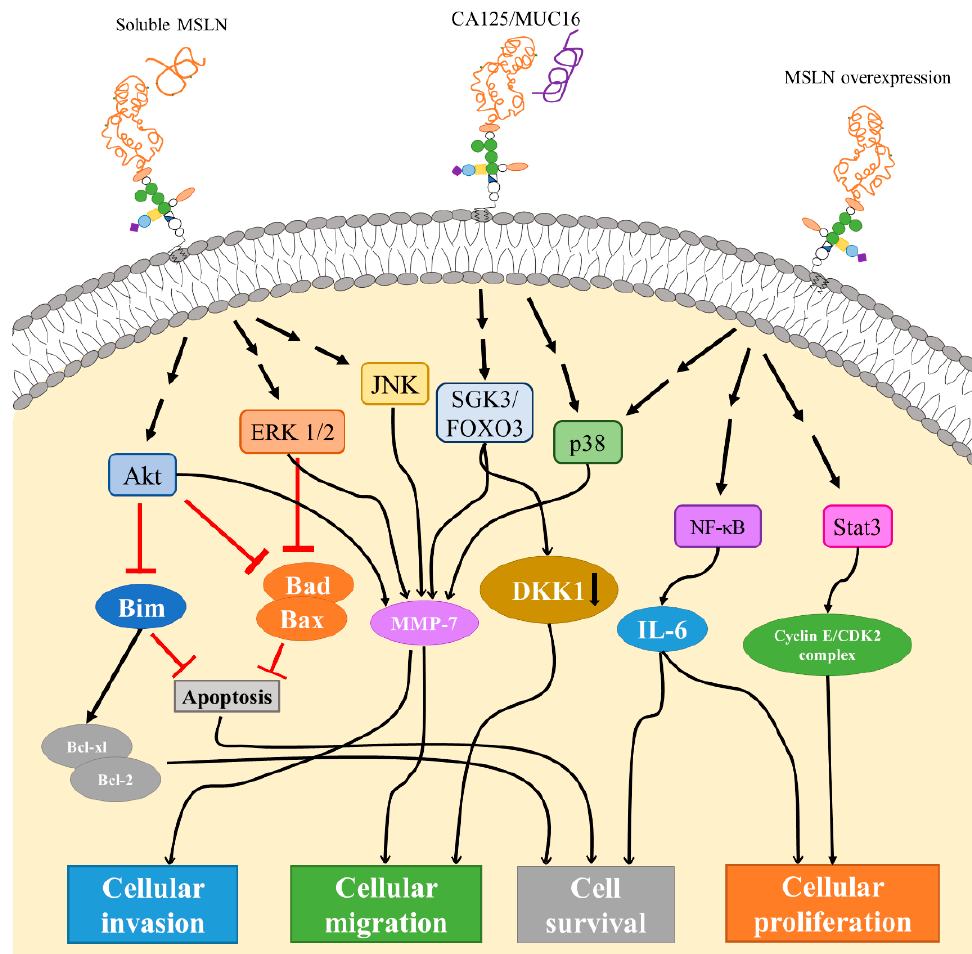
Figure 2. Signaling pathways associated with mesothelin. Through interactions with soluble or cell surface mesothelin, mesothelin can trigger Akt, ERK1/2, and JNK signaling pathways. Downstream effects of Akt and ERK1/2 signaling include inhibition of Bim, Bad, and Bax, which then inhibits apoptosis and/or stimulate Bcl-xl/Bcl-2 leading to cell survival. The Akt, ERK1/2, and JNK pathways are shown to increase expression of matrix metalloprotease 7 (MMP-7), which leads to increased rates of cellular migration and invasion. MMP-7 pathway can also be triggered through SGK3/FOXO3 and p38 pathways. SGK3/FOXO3 signaling has also been shown to cause the downregulation and expression of DKK1, thus increasing cell migration. In general, overexpression of mesothelin also causes p38 signaling activation, as well as NF-kB and STAT3 signaling. NF-kB downstream effect increases expression of IL-6 and contributes to cell survival and proliferation, while STAT3 signaling has been indicated in Cyclin E/CDK2 complex formation, pushing the cell through the cell cycle, and increasing cell proliferation.